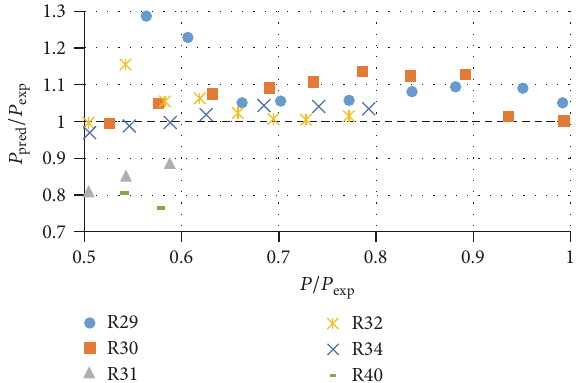
Figure 13: Predicted buckling load 𝑃 pred of an intact shell versus the maximum applied load 𝑃 used in VCT, normalized by experimental buckling load of the shell 𝑃 exp